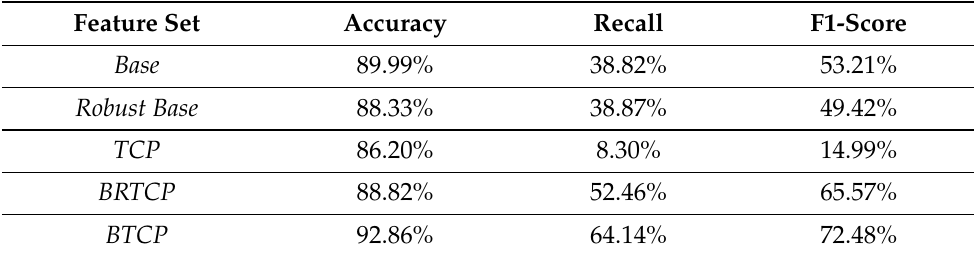
Table 4. Model performance—logistic